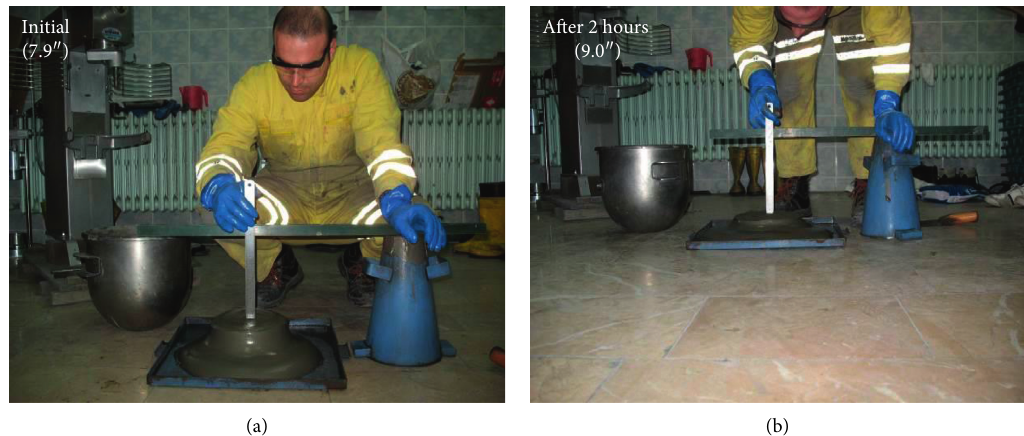
Figure 5: Slump levels of LSS-S/DT mixtures: (a) initial (7.9 inches) and (b) after 2 hours (9